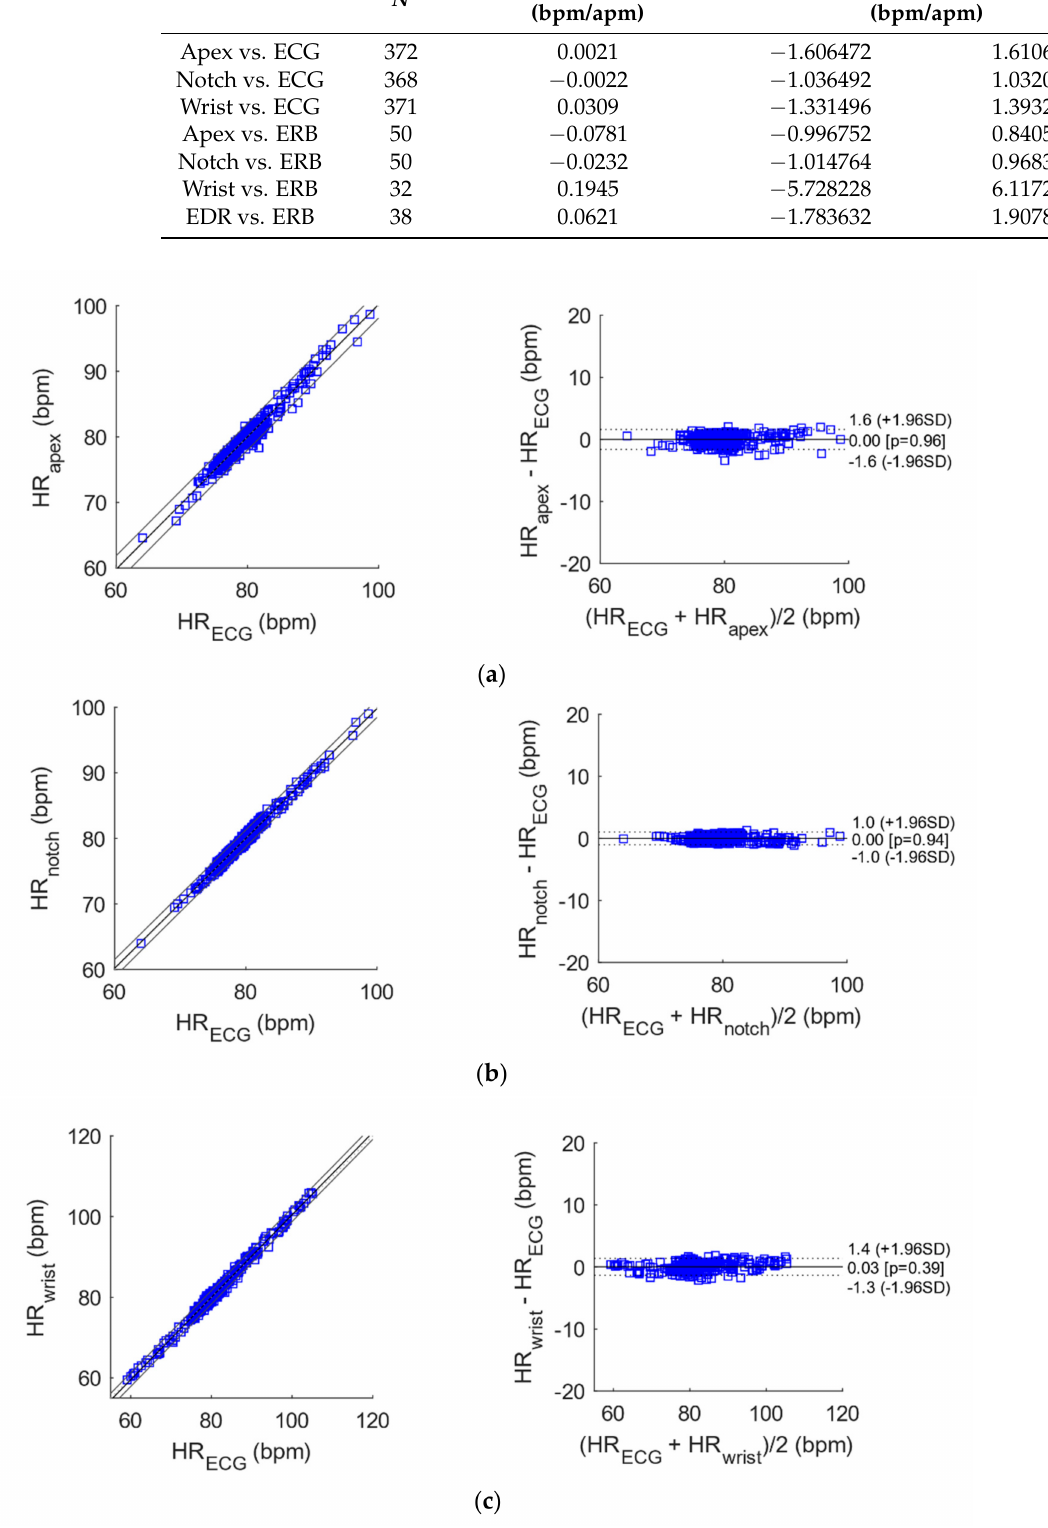
Figure 11. Correlation and Bland-Altman plots for the instantaneous heart rates extracted from ECG versus those extracted from the heart monitoring signals acquired by the proposed sensor from: ( a ) heart apex; ( b ) suprasternal notch; ( c )